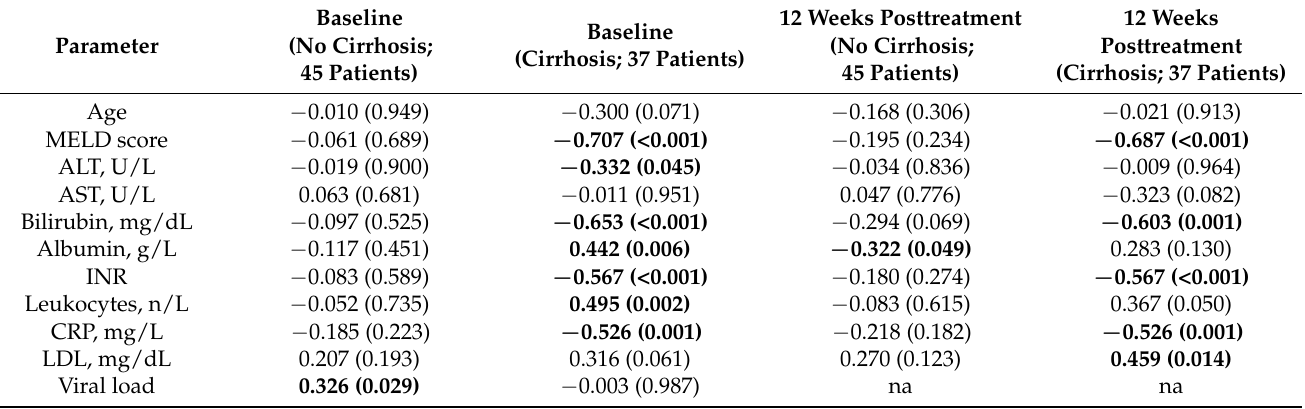
Table 4. Spearman correlation coefficients and p -values (in brackets) for the correlations of PCSK9 with age, MELD score, viral load and routine laboratory parameters in the HCV patients with and without liver cirrhosis before direct-acting antiviral (DAA) therapy, and 12 weeks